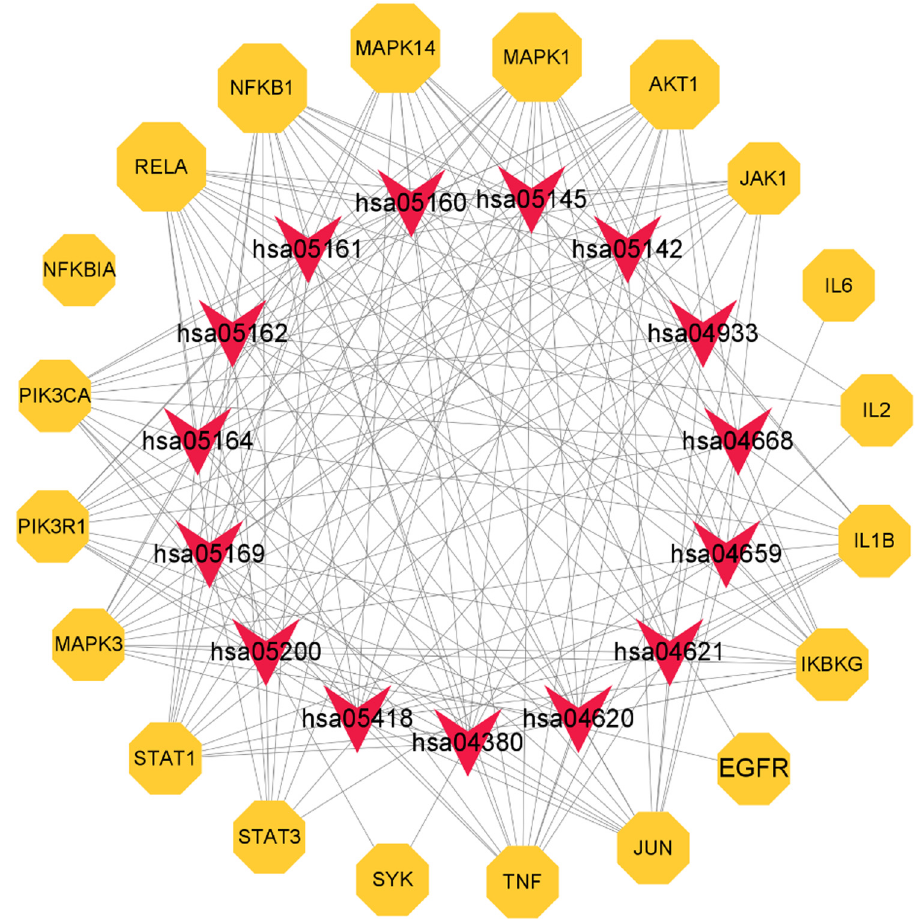
Figure 5: Key target – pathway network. The yellow octagons are the key targets, and the red V shapes are the